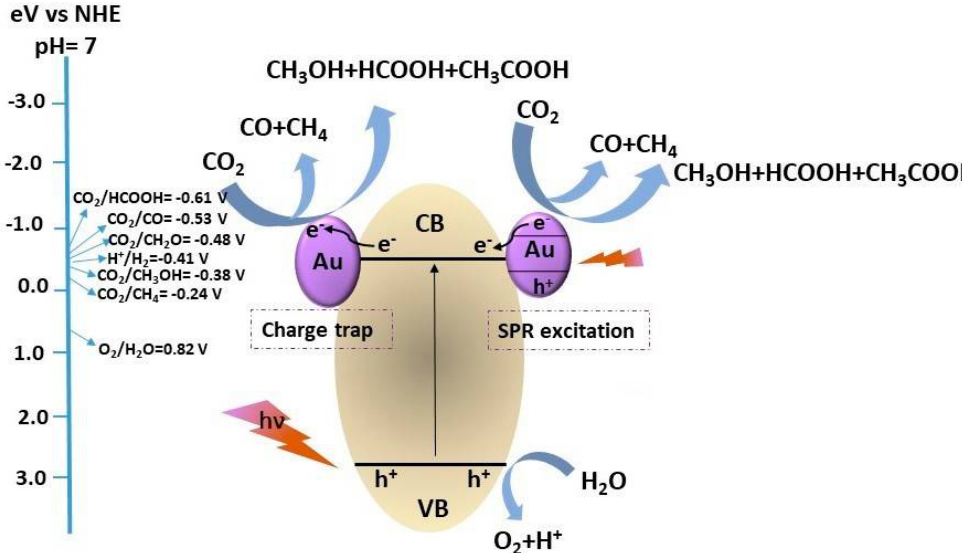
Figure 2. Simplified reaction mechanism of the CO 2 photoreduction over a photocatalyst [14], reproduced with permission from [Bahadori, E.; Tripodi, A.; Villa, A.; Pirola, C.; Prati, L.; Ramis, G.; Rossetti], [Catalysts]; published by [MDPI],